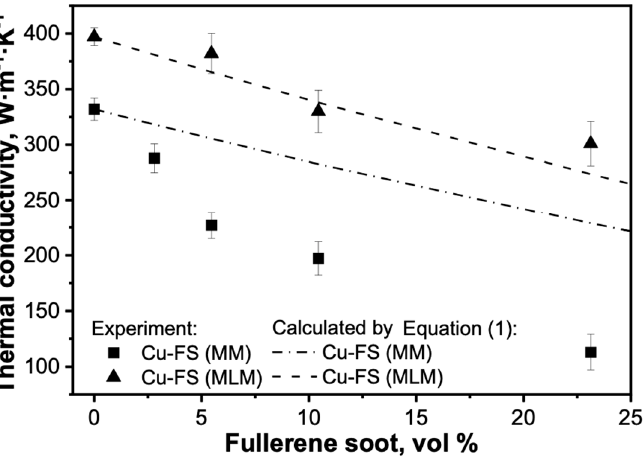
◦ C as a function of FS